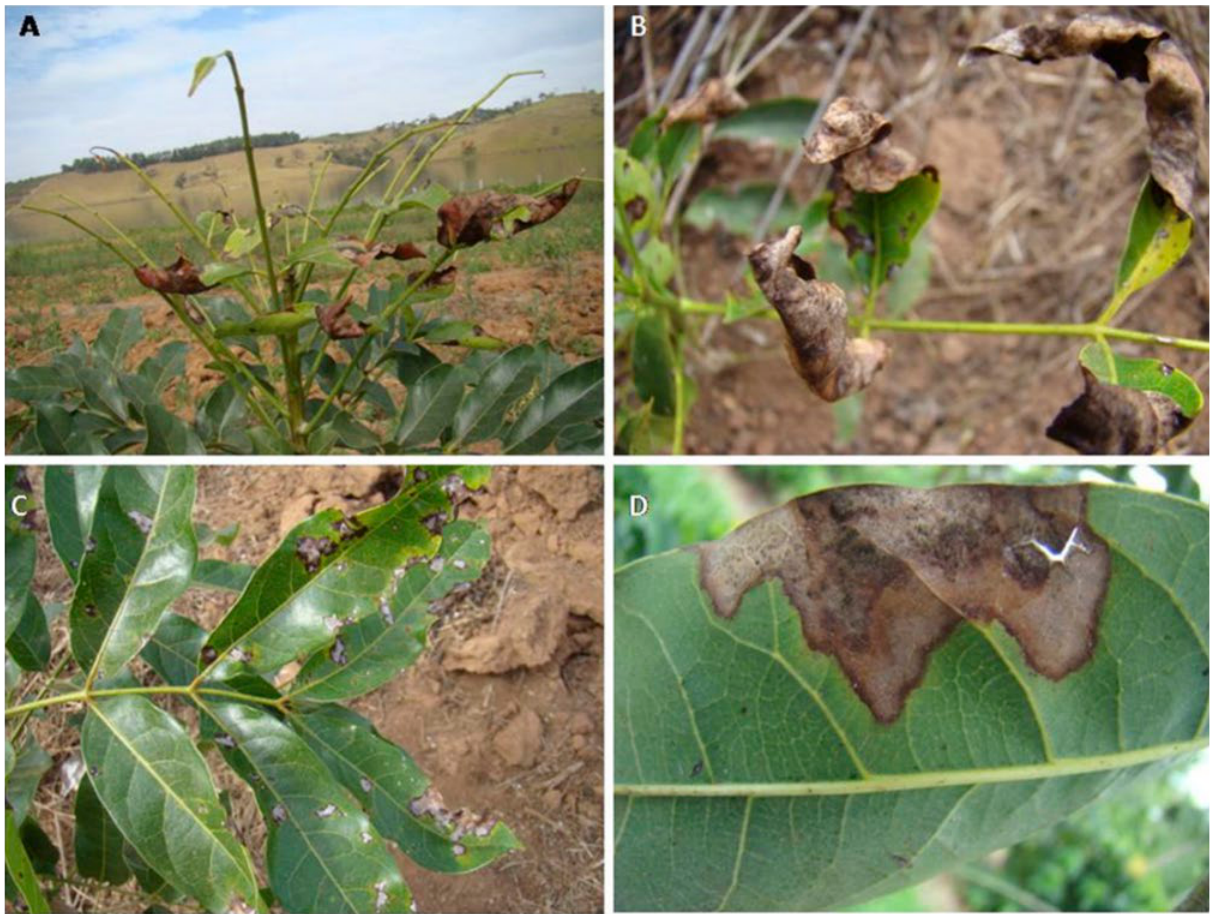
Figure 1. Leaf spot symptoms caused by Alternaria argyroxiphii on Khaya senegalensis. (A) Defoliation; (B) Leaf rolling symp - toms; (C and D) Symptoms showing colonization mainly in the leaf